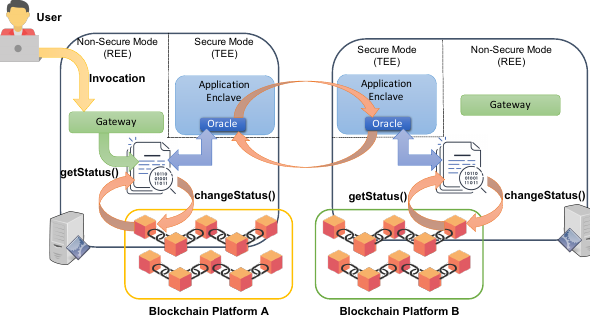
Figure 5. Proposed TEE-based interoperability solution.